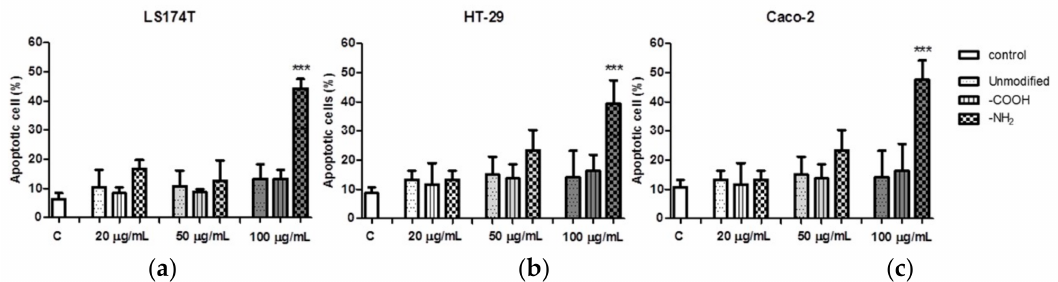
Figure 7. Effect of polystyrene nanoparticles on ( a ) LS174T; ( b ) HT-29; and ( c ) Caco-2 cell apoptosis. Data are presented as mean ± SD of n ≥ 3. One-way ANOVA followed by Tukey–Kramer multiple comparison post-test. *** p < 0.001 vs